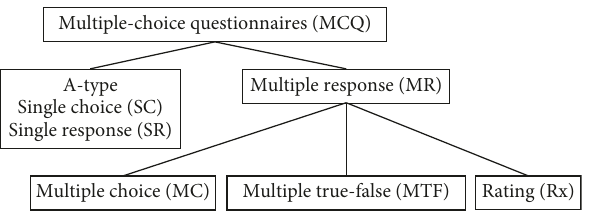
Figure 1: Systematization of question types.